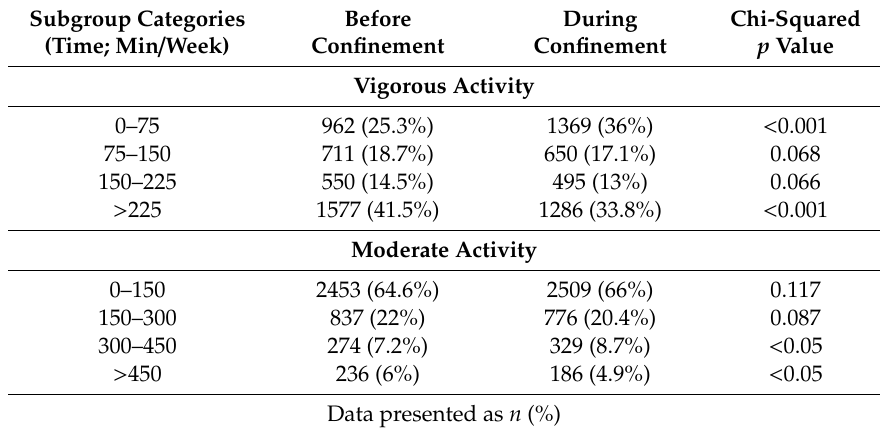
Table 3. Subgroup analysis in di ff erent ranges of physical activity levels before and during